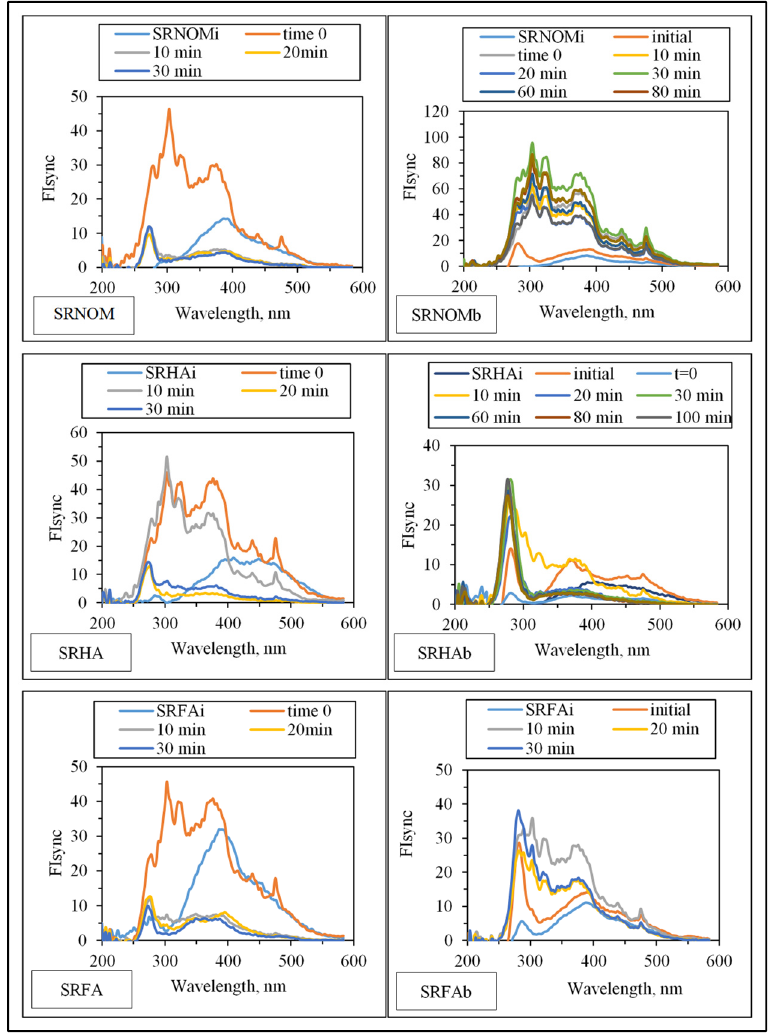
Figure 7. Synchronous scan fluorescence spectral features of the organic matrix upon solar photocatalytic degradation of NOM compounds in the absence/presence of E. coli (b denotes bacteria).